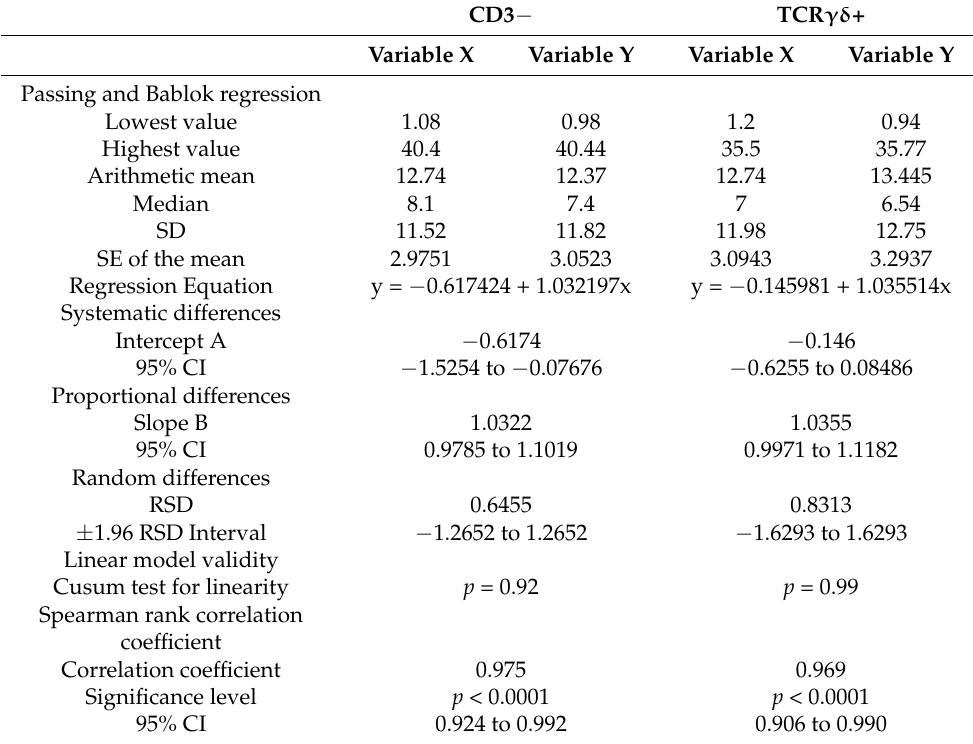
Table A2. Comparison of the different lymphocyte subpopulation data obtained using BD FACSCalibur and BD FACSCanto in the same centre (CATLAB) ( n = 15). Variable X shows data obtained with the BD FACSCanto cytometer and variable Y shows data obtained with the BD FACSCalibur cytometer. CD3 −